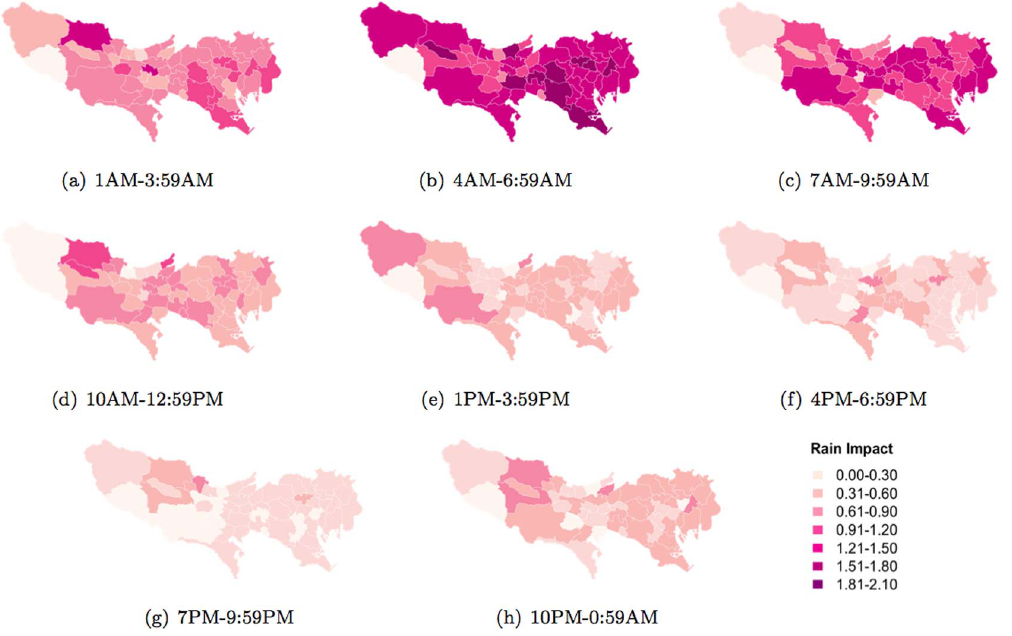
Figure 16. Rain impact (change in entropy between normal and abnormal temperatures) on daily activity patterns across different municipalities.